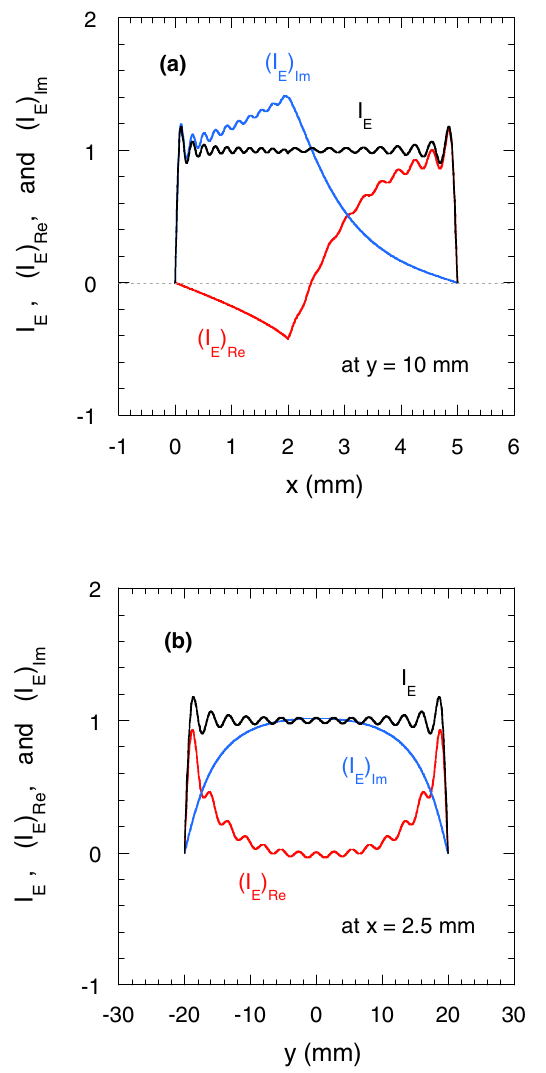
(cid:2) (cid:2) , (cid:1) I , and (cid:1) I for H H H Re Im